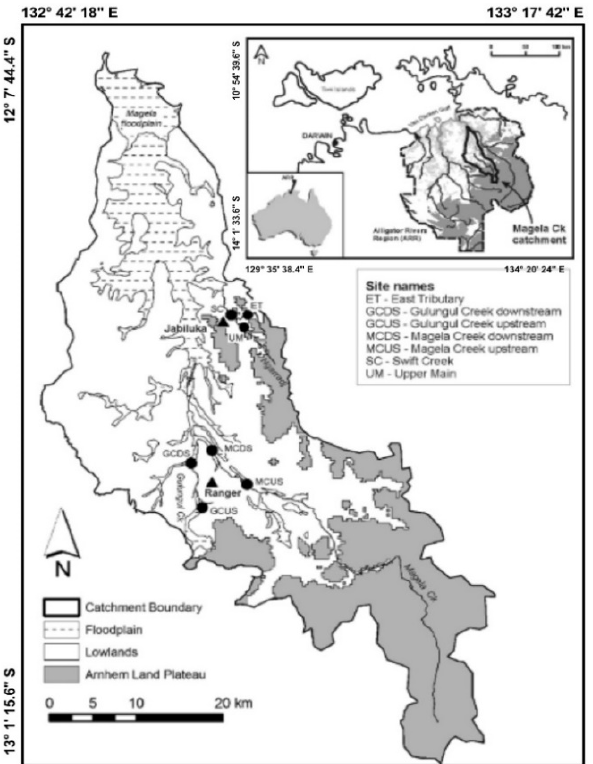
Figure 4. Location of gauging stations at Ranger. Adapted from [36]; copyright Commonwealth of Australia.